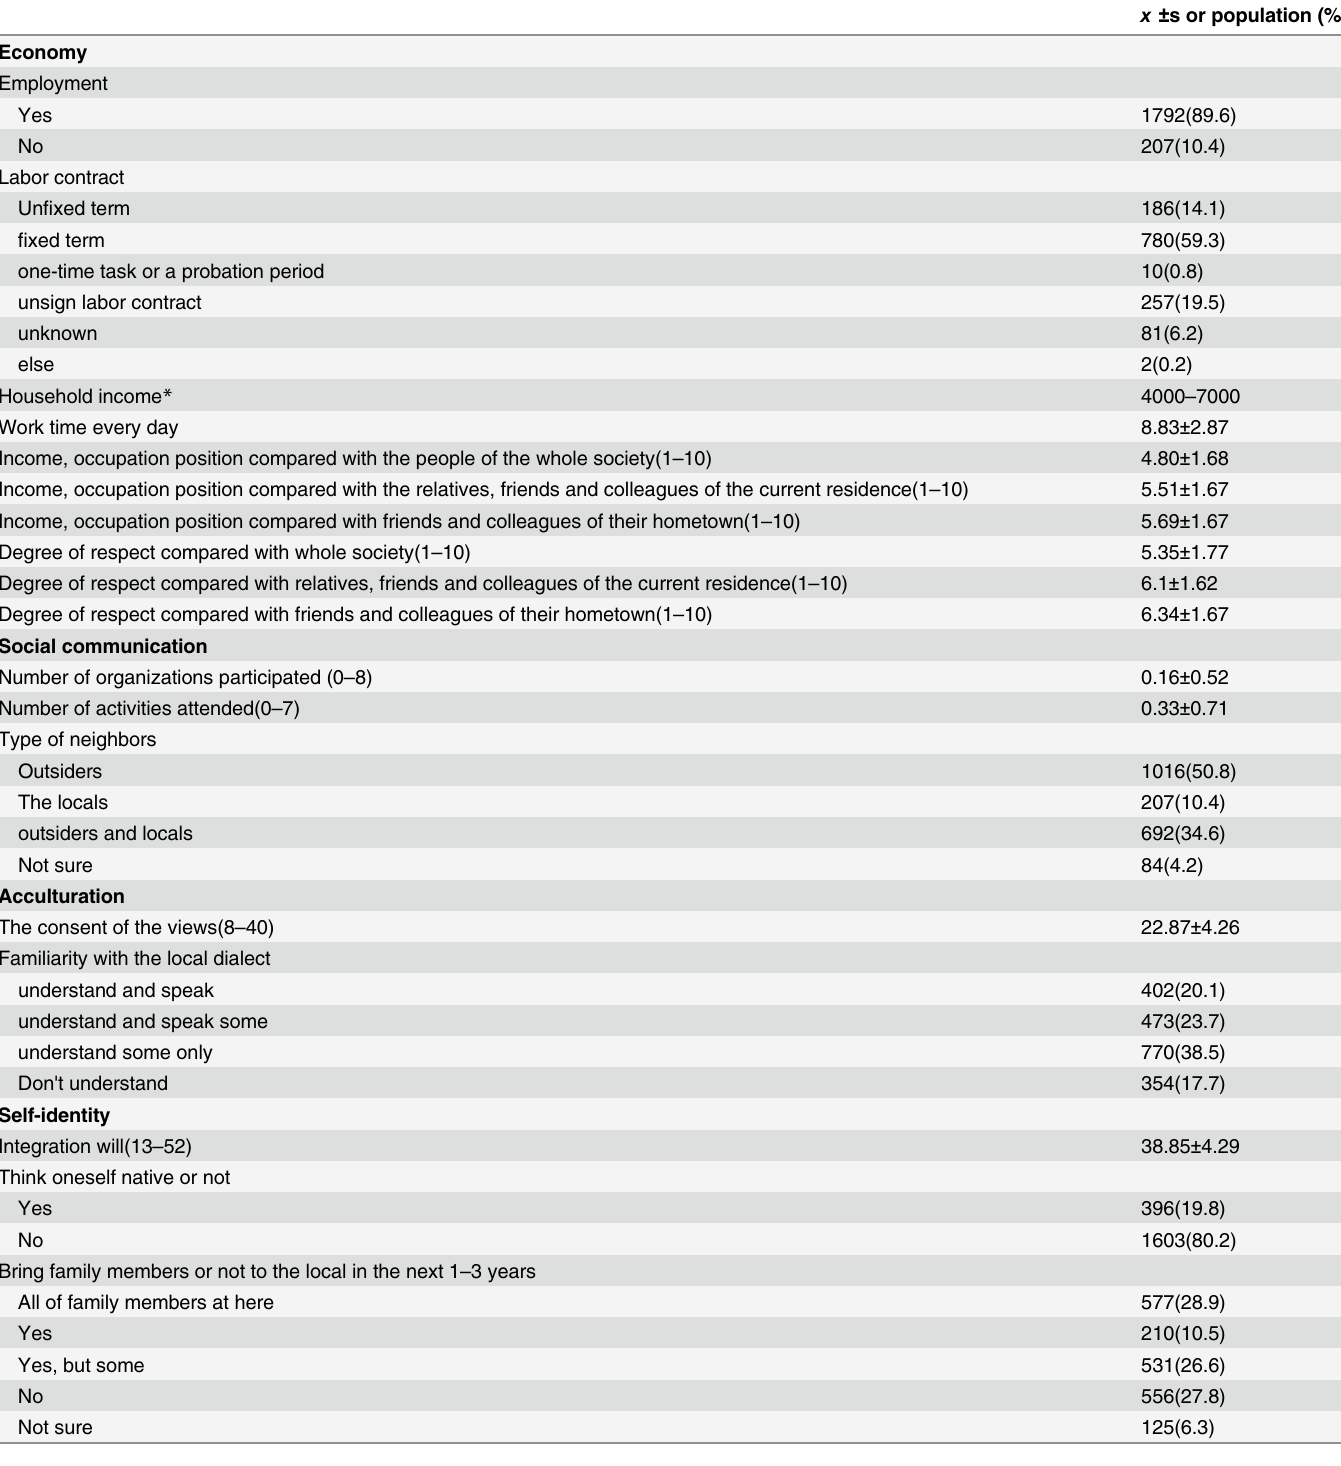
Table 3. Internal Migrants ’ Social Integration in 2014 in